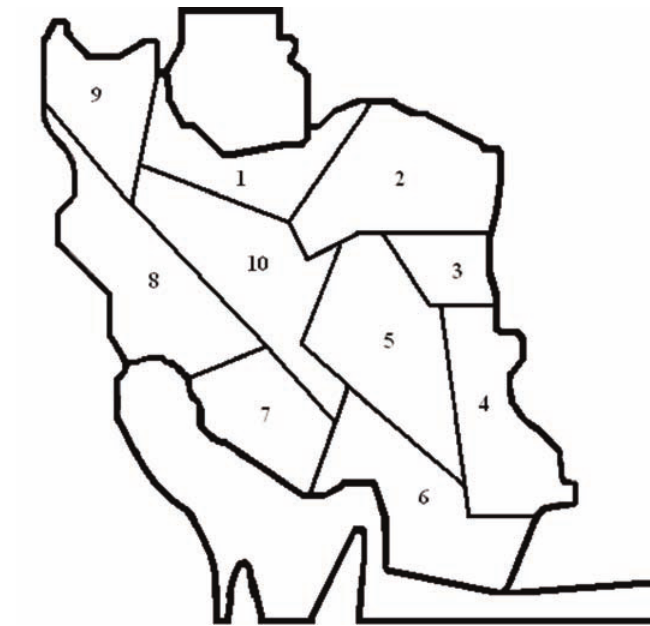
Figure 2. The siesmogenic source zones of Iran, as proposed by K94 [from Karakaisis 1994; re-edited by Sadeghian and Jalali-Naini 2008b].